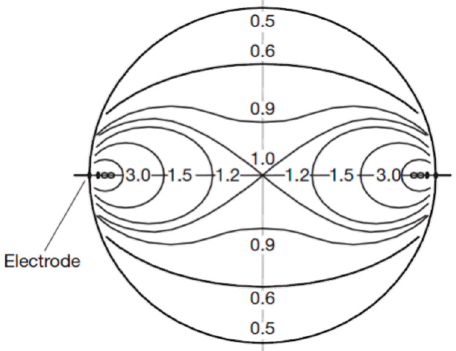
Figure 4. Weighting factor distribution W in the electrode plane [1].